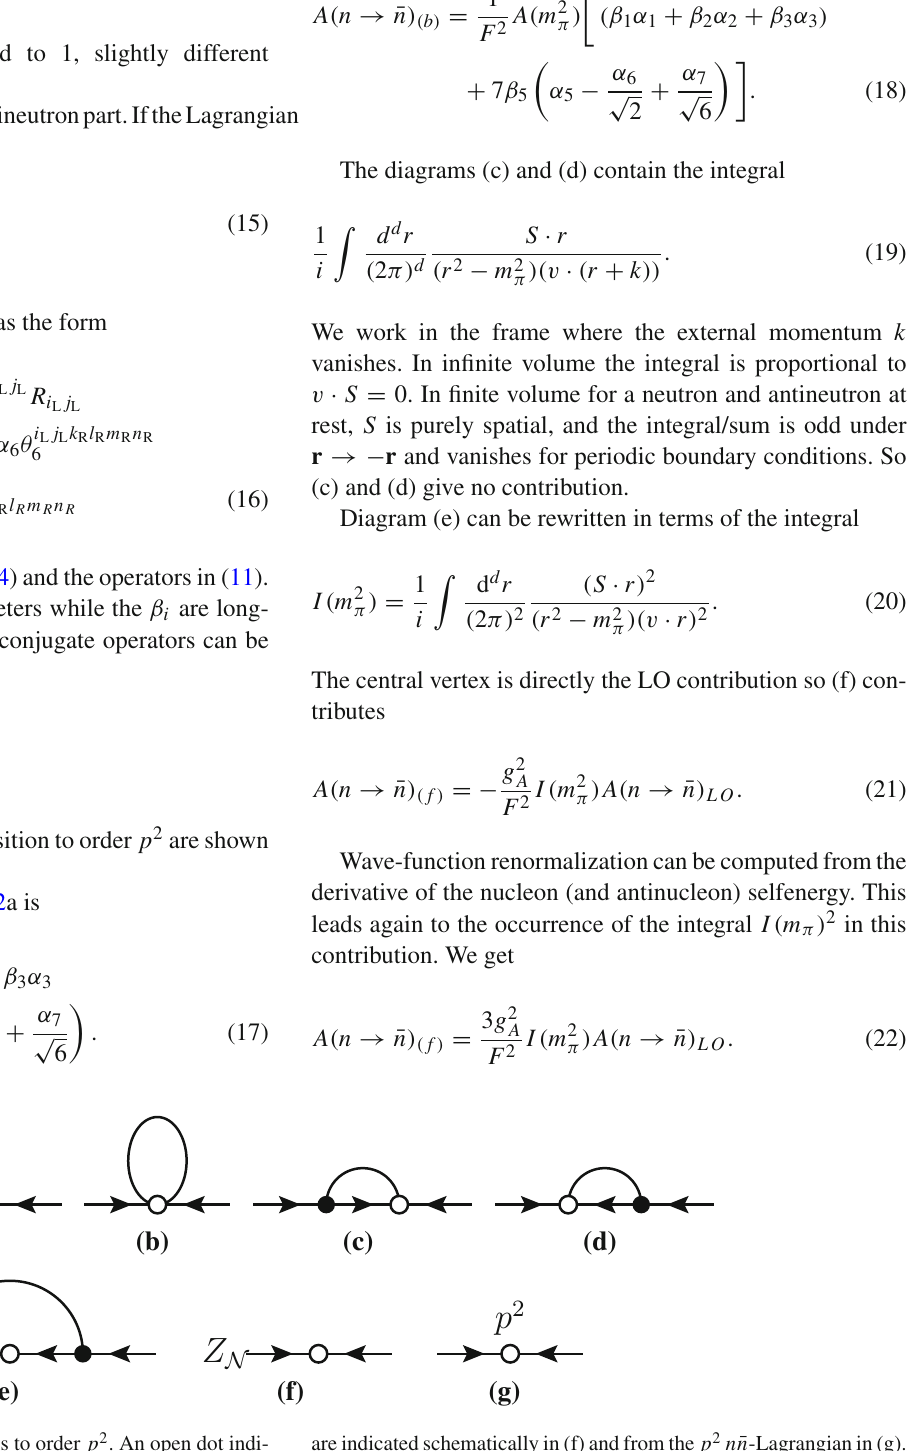
are indicated schematically in (f) and from the p 2 n ¯ n -Lagrangian in (g). A right-pointing line is a neutron, a left-pointing line an